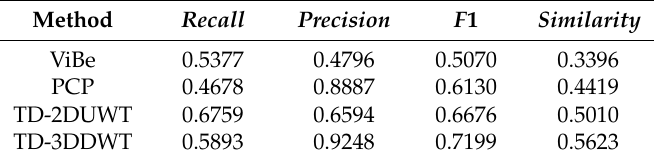
Table 2. Comparison of metrics for the 10th frame of AP96 (Frame 3409).